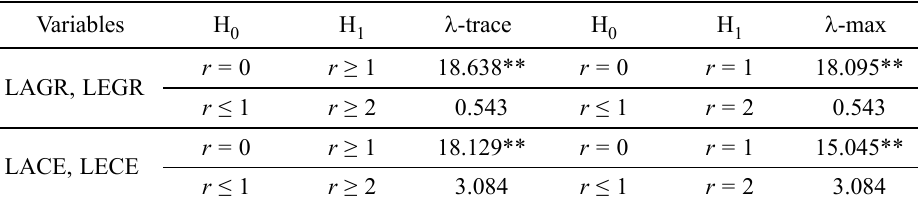
Table 1. Johansen and Juselius cointegration test